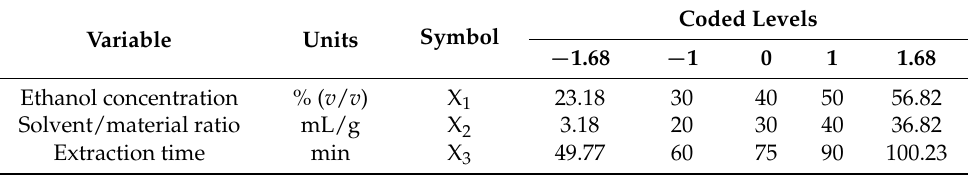
Table 5. Five levels of the three variables of the extraction